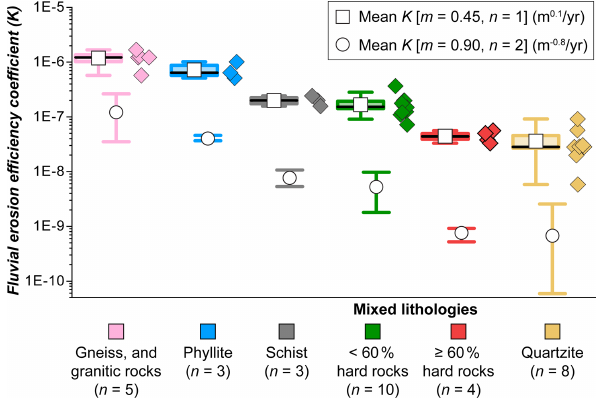
Figure 6. Lithology controls the fluvial erosion efficiency coeffi- cient ( K ) in the study area. Boxplot elements are as follows: box range represents the standard error of the mean, whisker range shows the interval between the 10th and 90th percentiles of the data, and the thick black line shows the median values. Note that we cal- culated K assuming (i) m = 0 . 45 and n = 1 (derived values of K have units of m 0 . 1 yr − 1 ) and (ii) m = 0 . 9 and n = 2 (derived values of K have units of m − 0 . 8 yr − 1 ). For the case of n = 1, we show the boxplot on the left and raw data (diamonds) on the right. See Table S1 for data on each of the catchments analysed, including lithology and mean annual precipitation